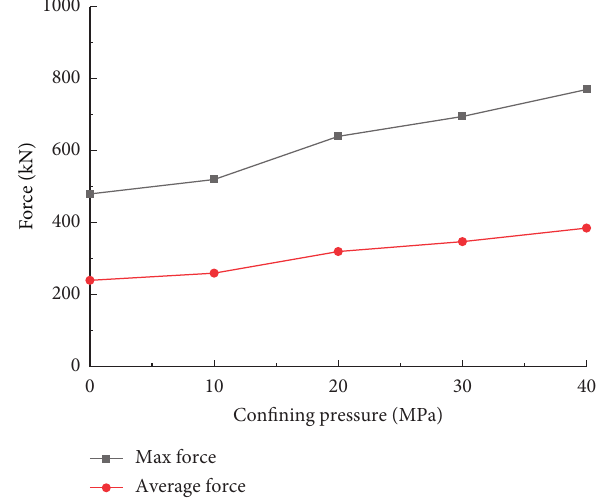
Figure 8: Vertical force of disc cutter under different confining